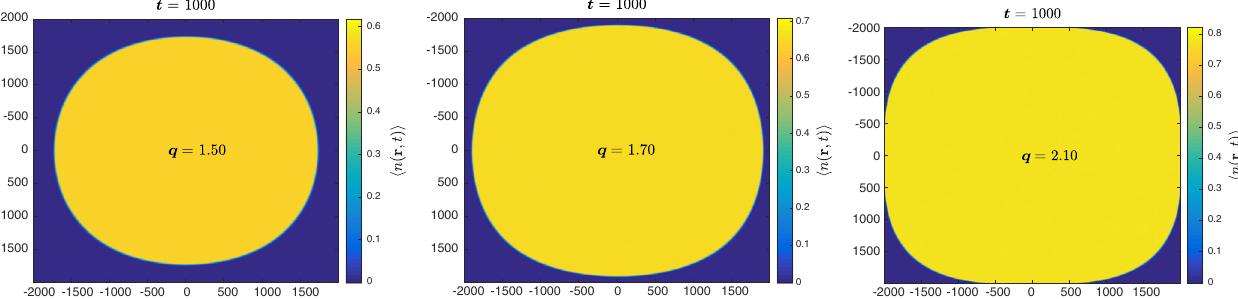
FIG. 10. “ Faceting ” of the cluster: Shown are the cluster shapes at fixed time t ¼ 10 3 , for the indicated values of q . When q is sufficiently large (third panel), the cluster develops facets along the θ ¼ 0 , π directions, where the normal growth speed is the maximum possible given the circuit geometry. The region shown is the naive light